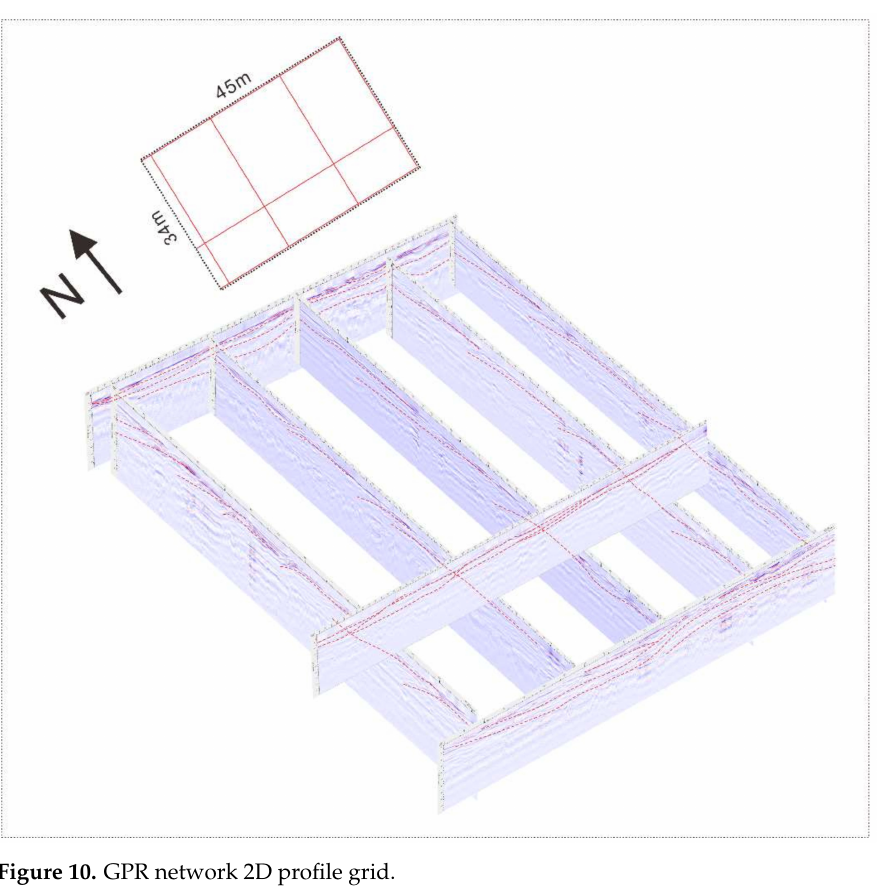
Figure 10. GPR network 2D profile grid.